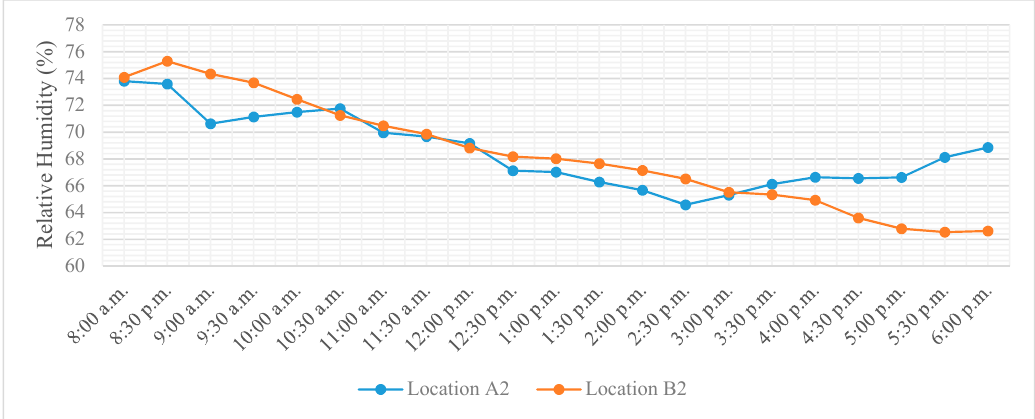
Figure 16. Indoor relative humidity in the room of Building A (Location A2) and Building B (Location B2).